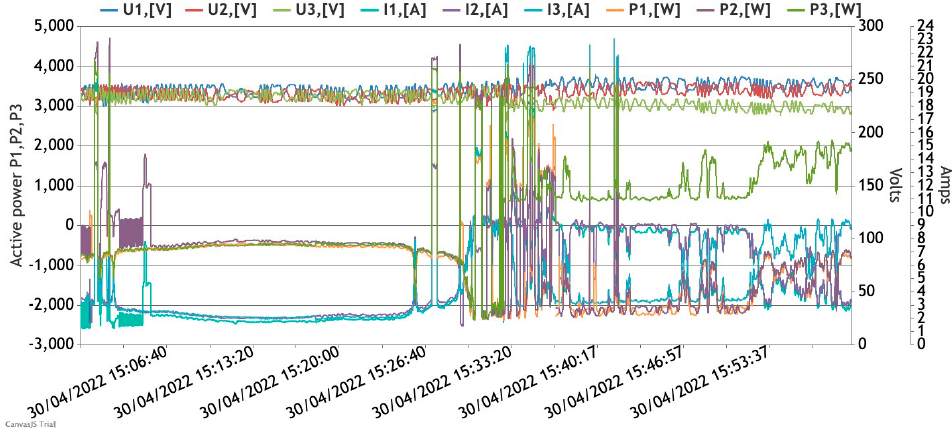
Figure 5. Measured voltage V, current I, power P, and power factor PF curves for each mains